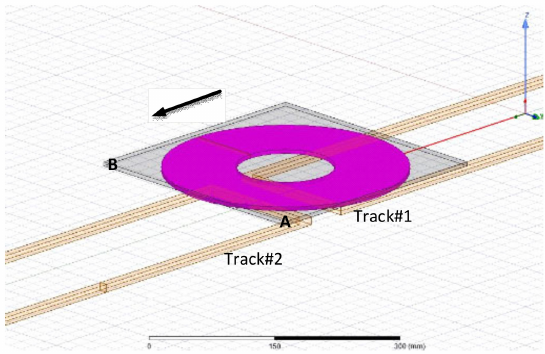
Figure 6. Three-dimensional simulation diagram.